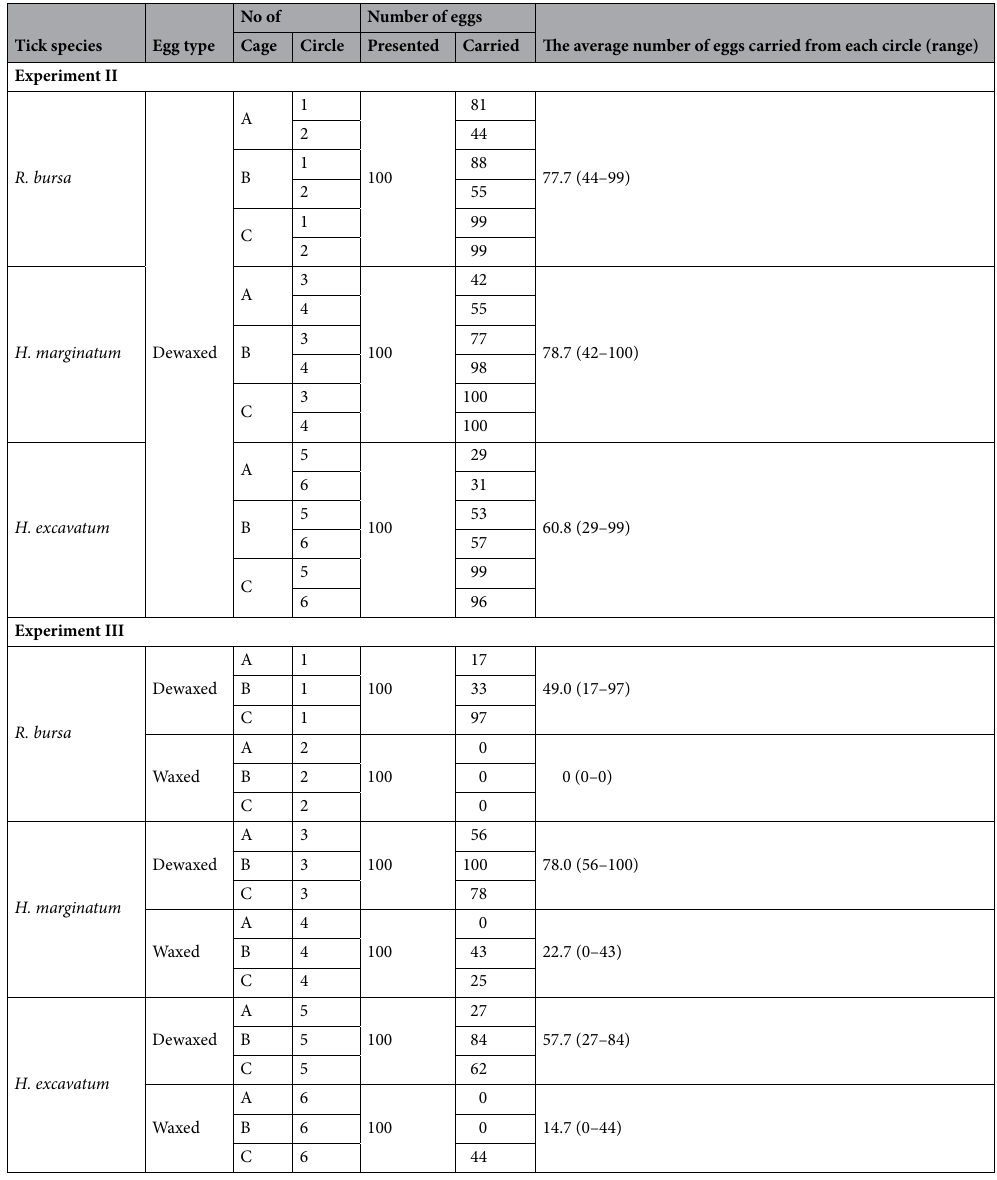
Table 2. The number of the waxed and dewaxed tick eggs carried by the ants within 24 h in Experiment II and